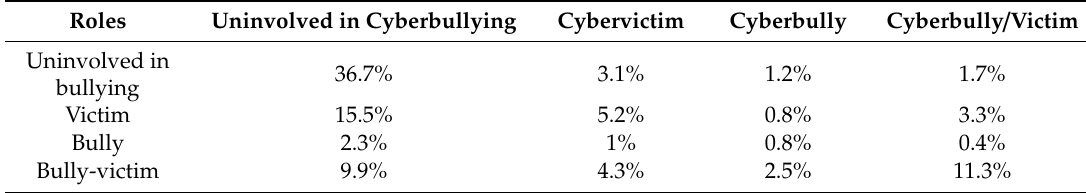
Table 1. Prevalence rates taking into account the overlap among bullying and cyberbullying roles.